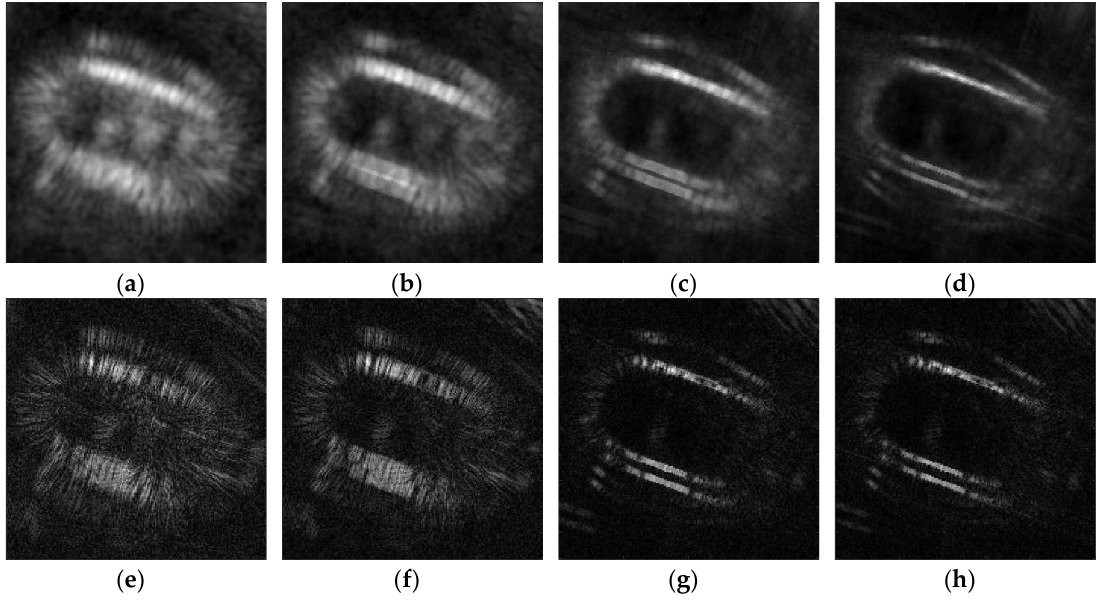
Figure 8. Imaging of vehicle targets in the Gotcha dataset by piecewise linear transformation with different thresholds: ( a , e ) No piecewise linear transform; ( b , f ) T = 0.5; ( c , g ) T = 0.8; ( d , h ) T = 0.9.